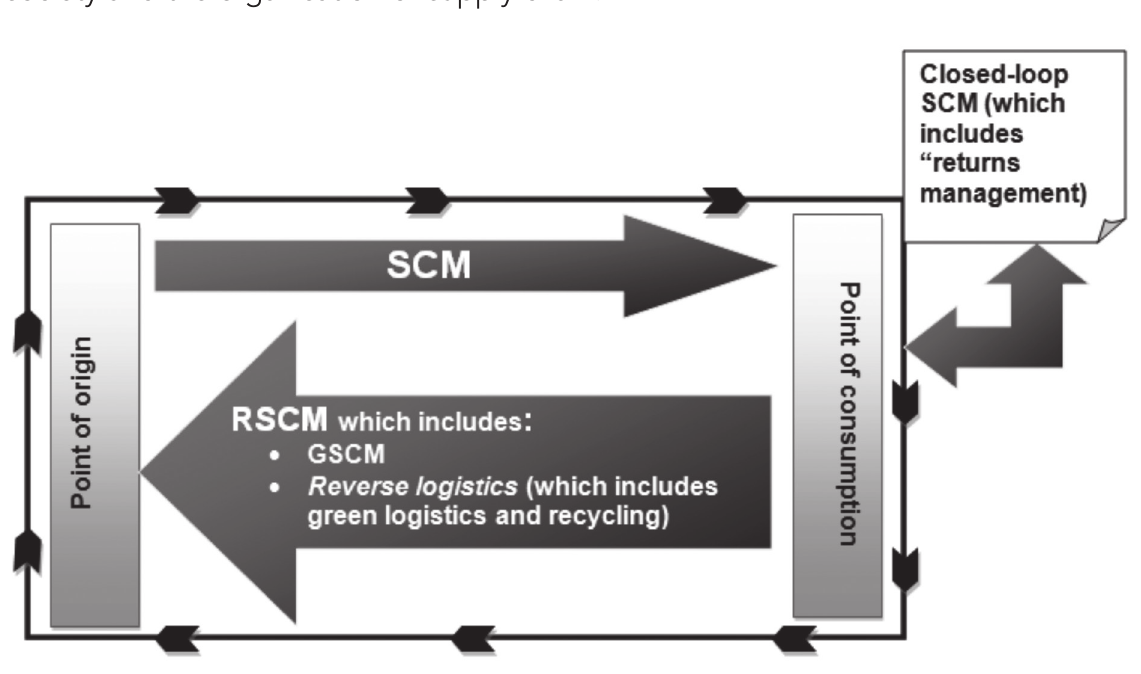
Figure 1: Reverse logistics and related concepts (Source: Compiled by